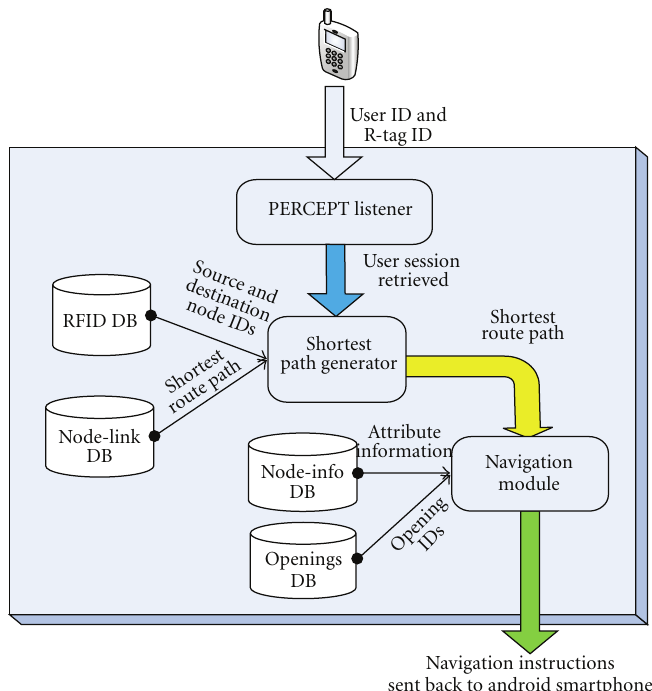
Figure 5: PERCEPT server